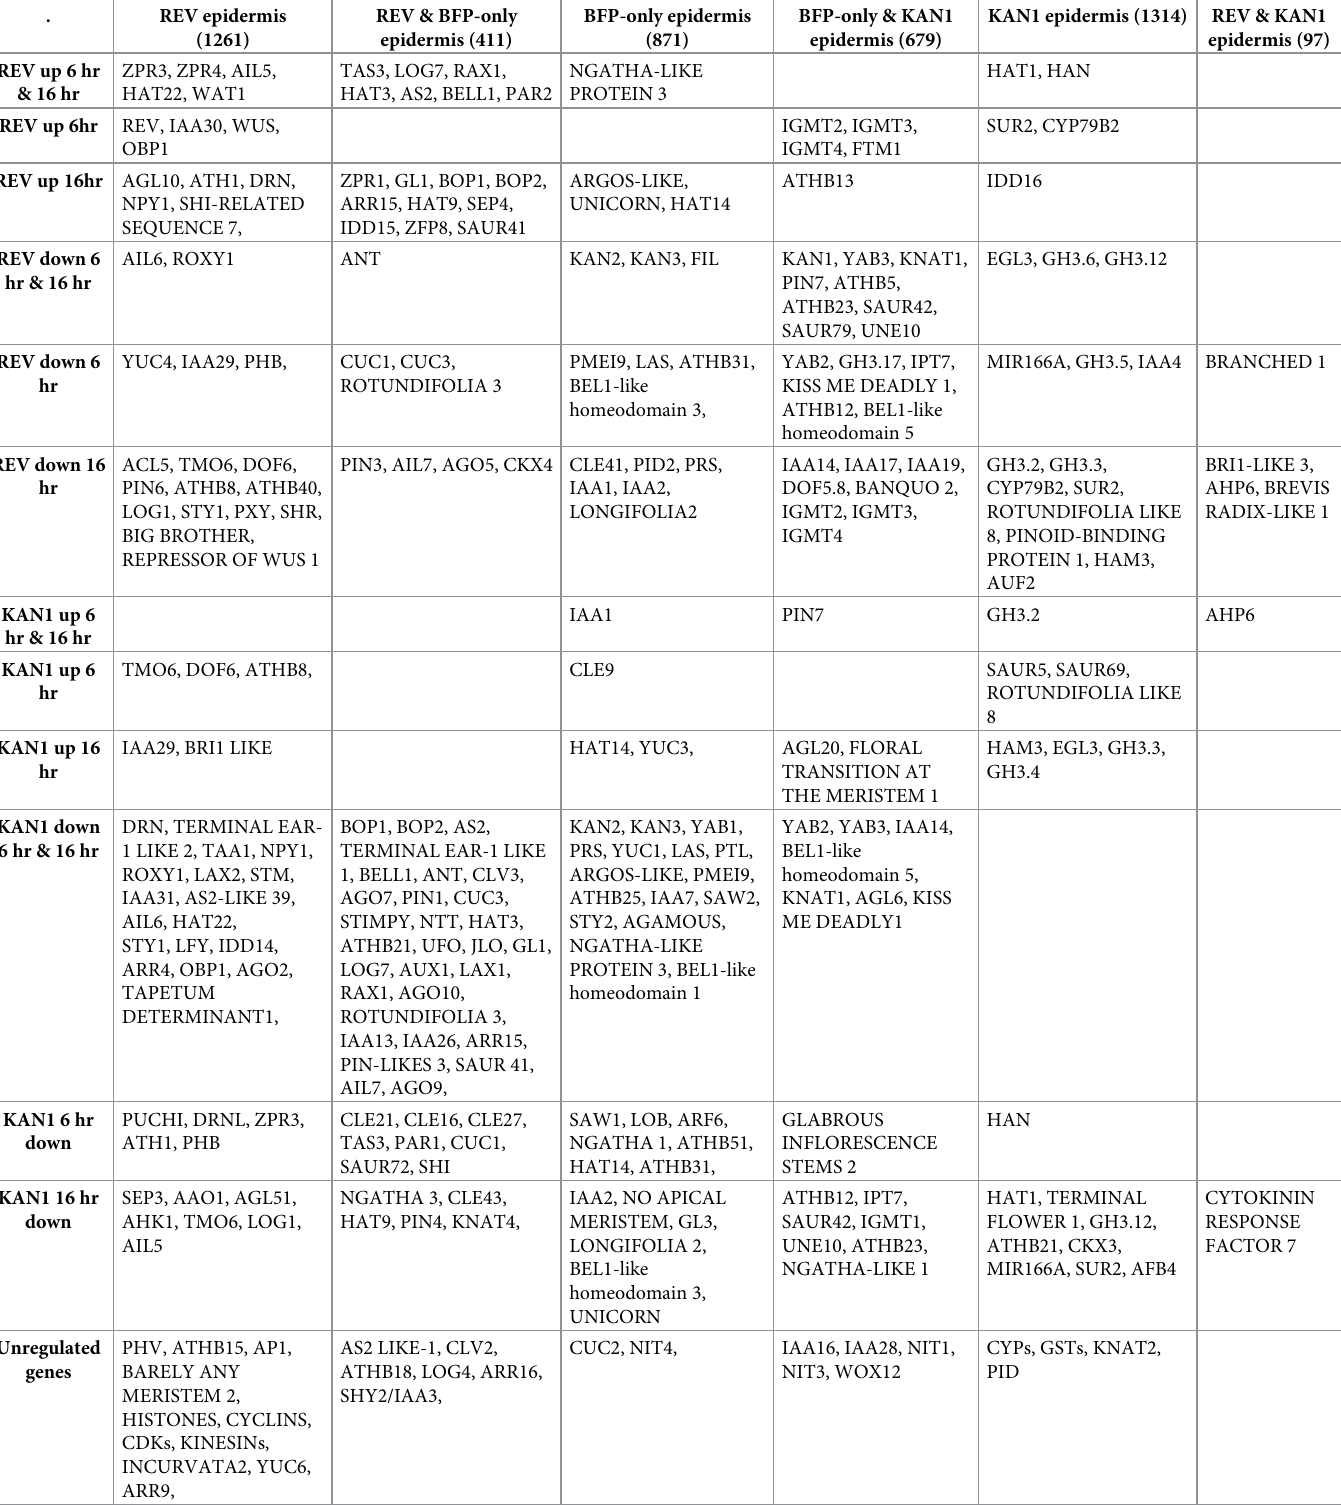
Table 3. Expression dynamics of selected development related genes.